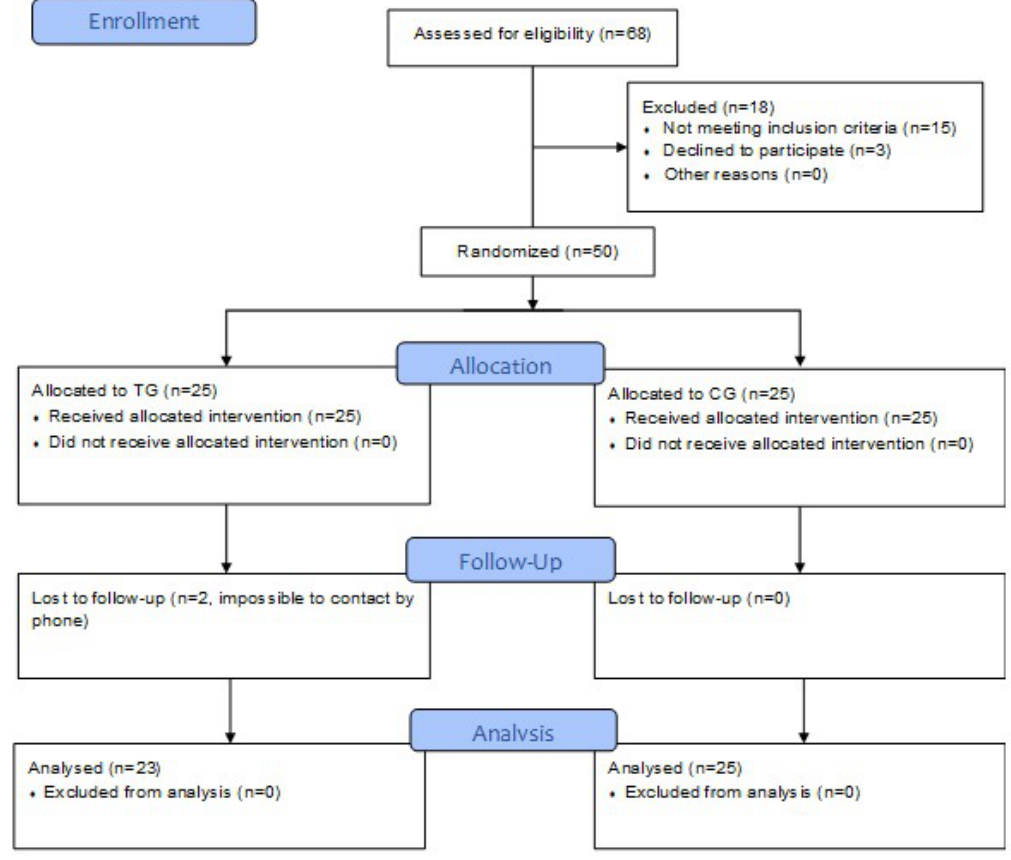
Figure 1. Flow Diagram.